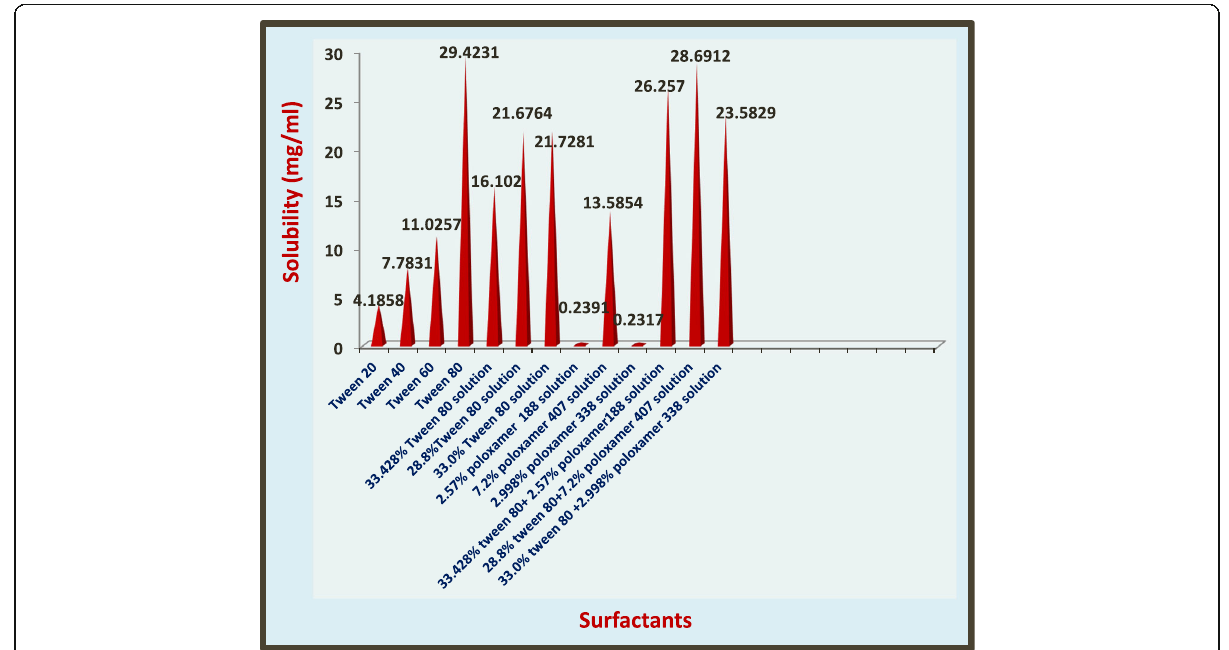
Fig. 2 Solubility study results of candesartan cilexetil in different surfactants